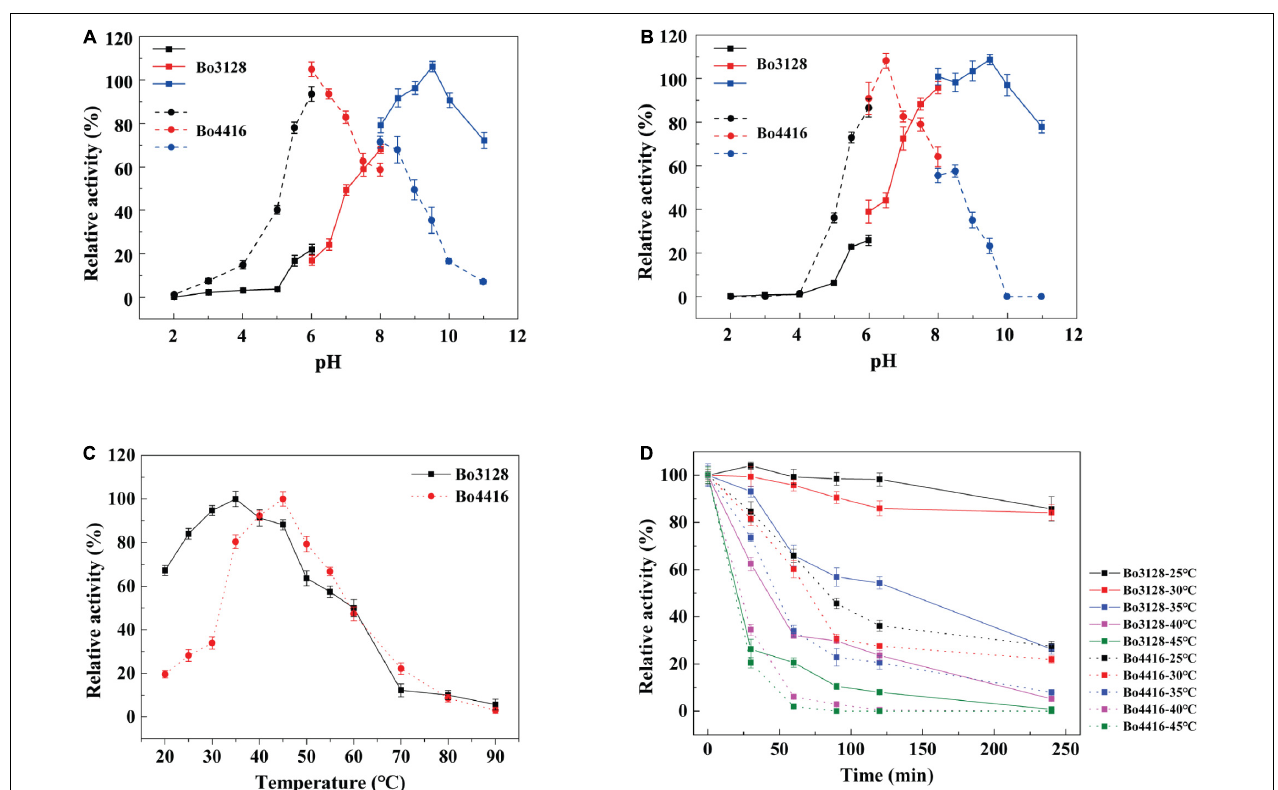
FIGURE 3 | (A) Optimal pH of Bo3128 and Bo4416. (B) pH stability of Bo3128 and Bo4416. (C) Optimal temperature of Bo3128 and Bo4416. (D) Temperature stability of Bo3128 and Bo4416. Relative activity was calculated by setting maximum activity as 100%. Error bars represent the standard deviation of three independent